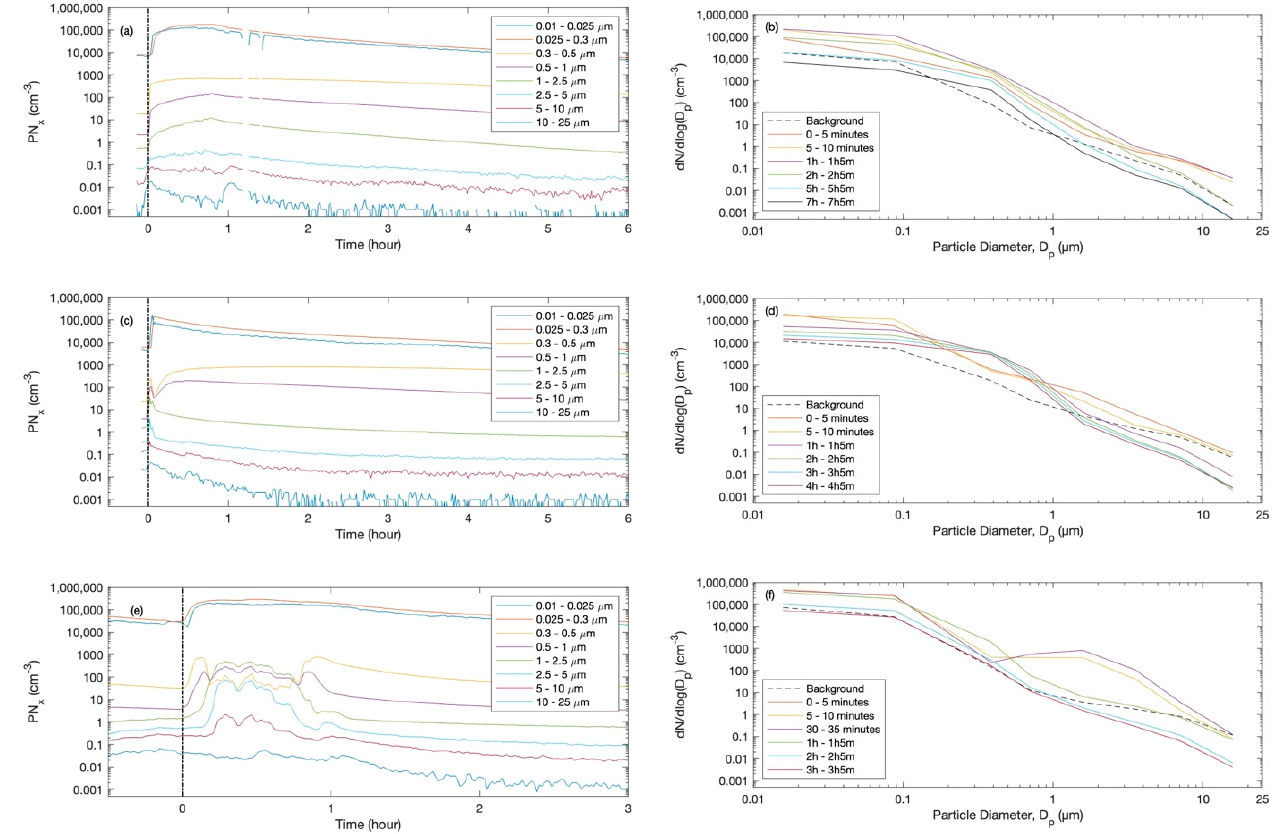
Figure 2. Particle number concentrations and size distributions during ( a , b ) incense stick burning, ( c , d ) cigarette smoking, and ( e , f ) shisha smoking. The left panel is the time series of different particle size fraction concentrations, where the vertical dashed line at zero hour indicates the start of the scenario, and the right panel is selected particle number size distributions during different time periods.